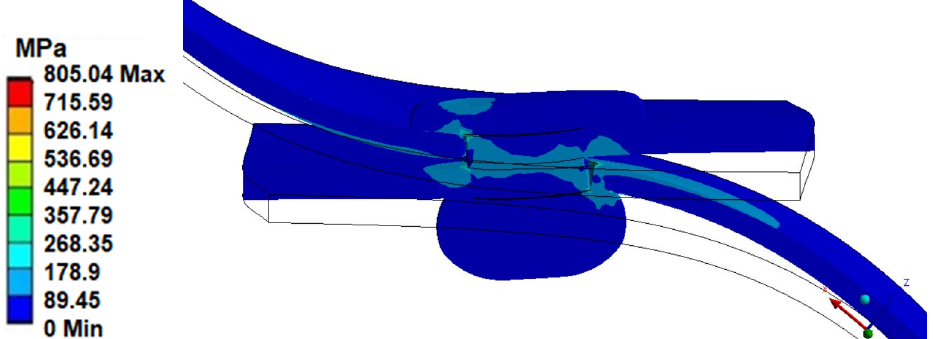
Figure 6. The equivalent stress of the joint connection.